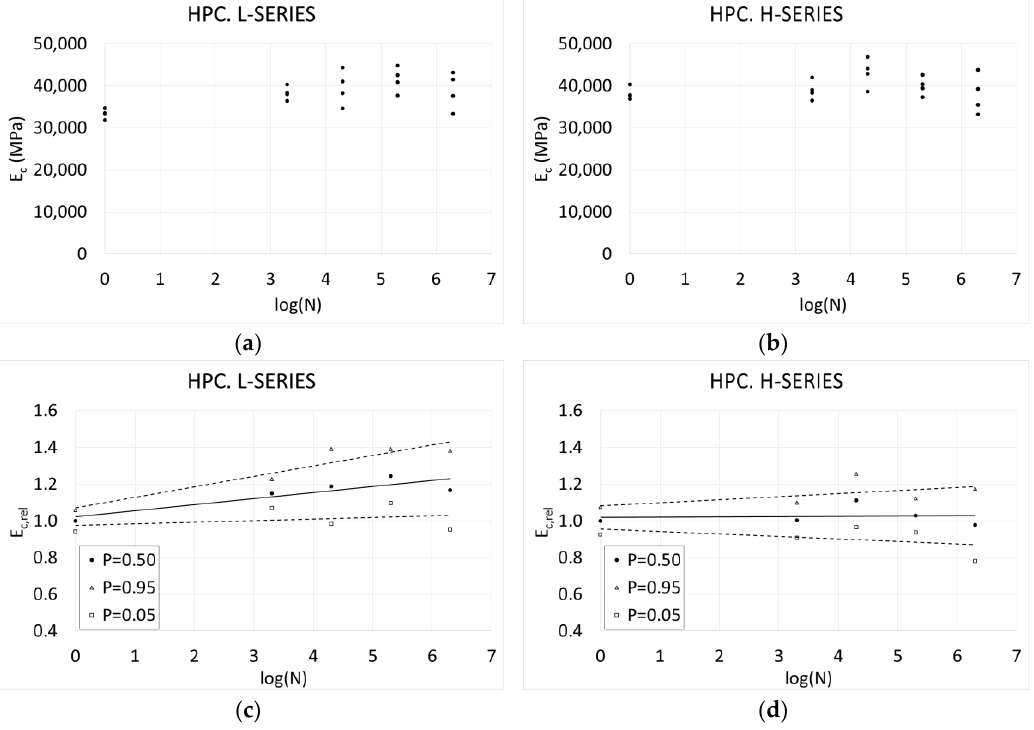
Figure 7. Variation of the compressive modulus of elasticity by number of cycles. HPC ( a ) L-Series. Raw values. ( b ) H-Series. Raw values. ( c ) L-Series. Maximum, minimum, and average relative values, and tendency lines. ( d ) H-Series. Maximum, minimum, and average relative values, and tendency lines.